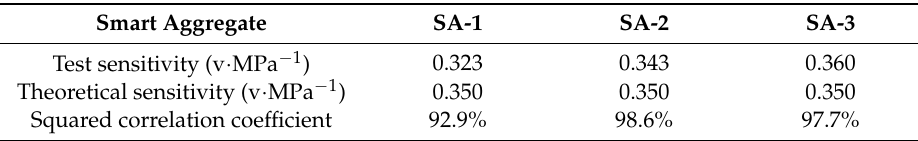
Table 2. Calibration result of smart aggregate under impact